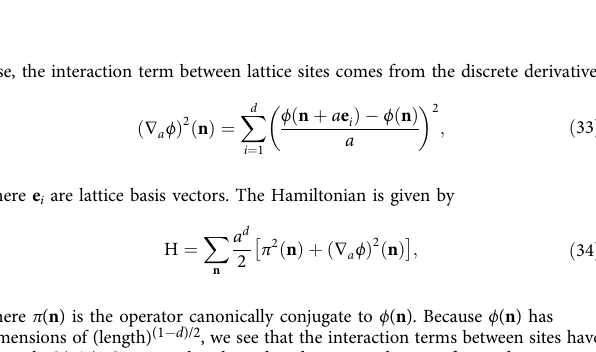
Fig. 4 Minimum energy cost of extracting entanglement for the toy model. More precisely, the fi gure shows the minimum change in energy Δ E when there is a decrease in zero entropy Δ S 0 (with S 0 equal to log 2 of the Schmidt rank) of the state of the physical system. When Δ S 0 is an integer m (which corresponds to extracting m EPR pairs from the system), then the plot shows Δ E = 0.5m. The calculation was performed using DMRG by restricting the bond dimension between Alice and Bob ’ s